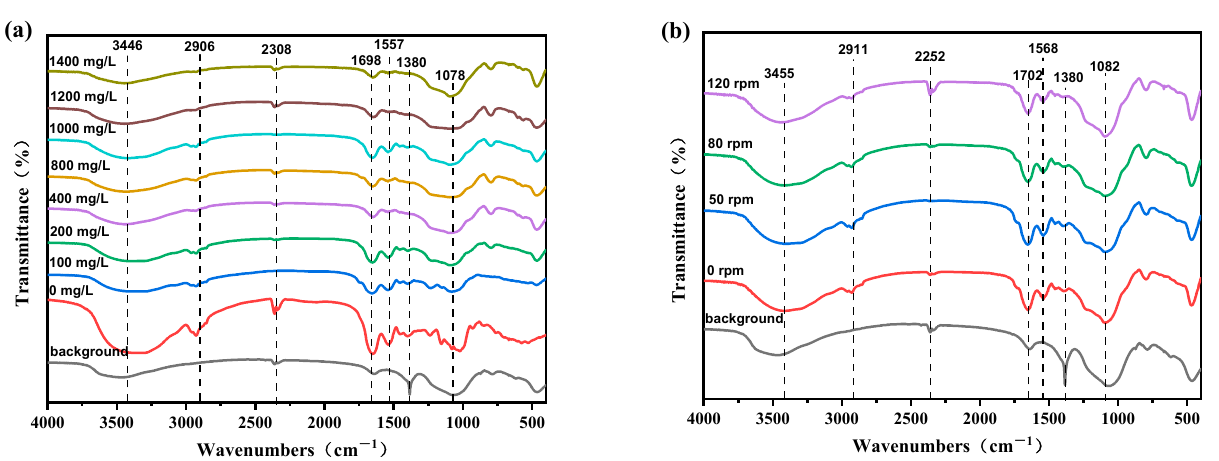
Figure 6. EPS infrared spectra under different particle concentrations ( a ) and hydraulic conditions ( b ).